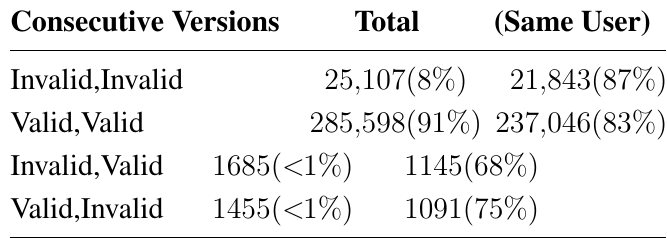
same contributor.